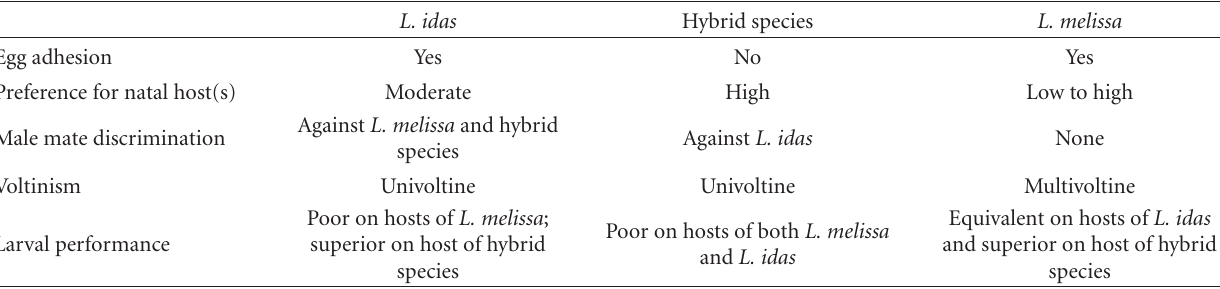
Table 3: Details of behavioral and ecological variation among taxa, specifically as variation relates to potential barriers to gene flow; see Figure 4 for a graphical interpretation of these traits in relation to gene flow. The descriptions of male mate discrimination refer to preferences of males for females of the other taxa. Details for larval performance refer to performance on the hosts of the other taxa relative to performance of the other taxa on those same